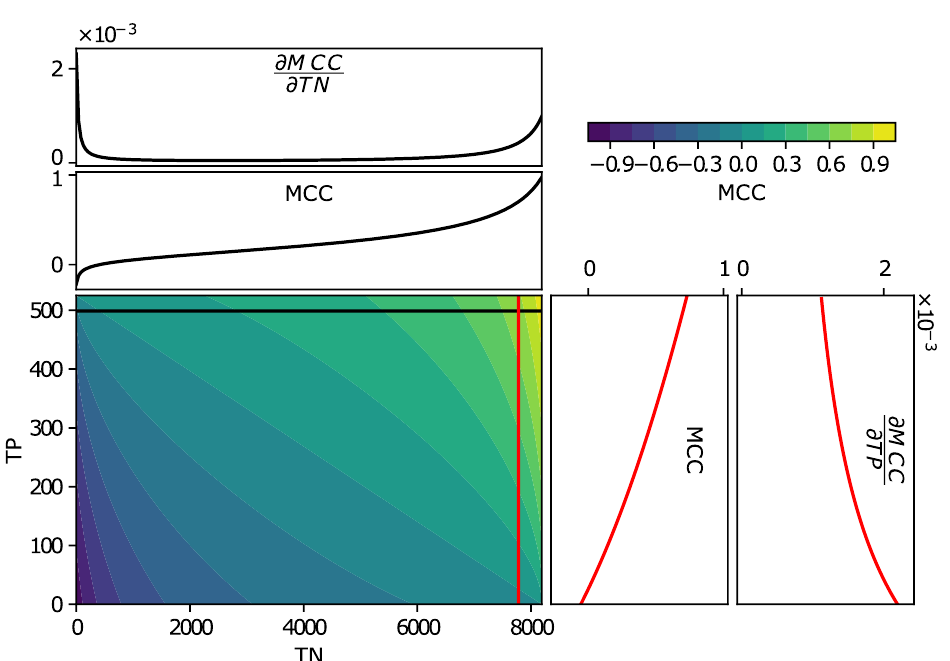
Figure 2. MCC: Colormap of the MCC. From colormap to top, TP = 95%, MCC, and its derivative as a function of TN. From colormap to right, TN = 95%, MCC, and its derivative as a function of TP.